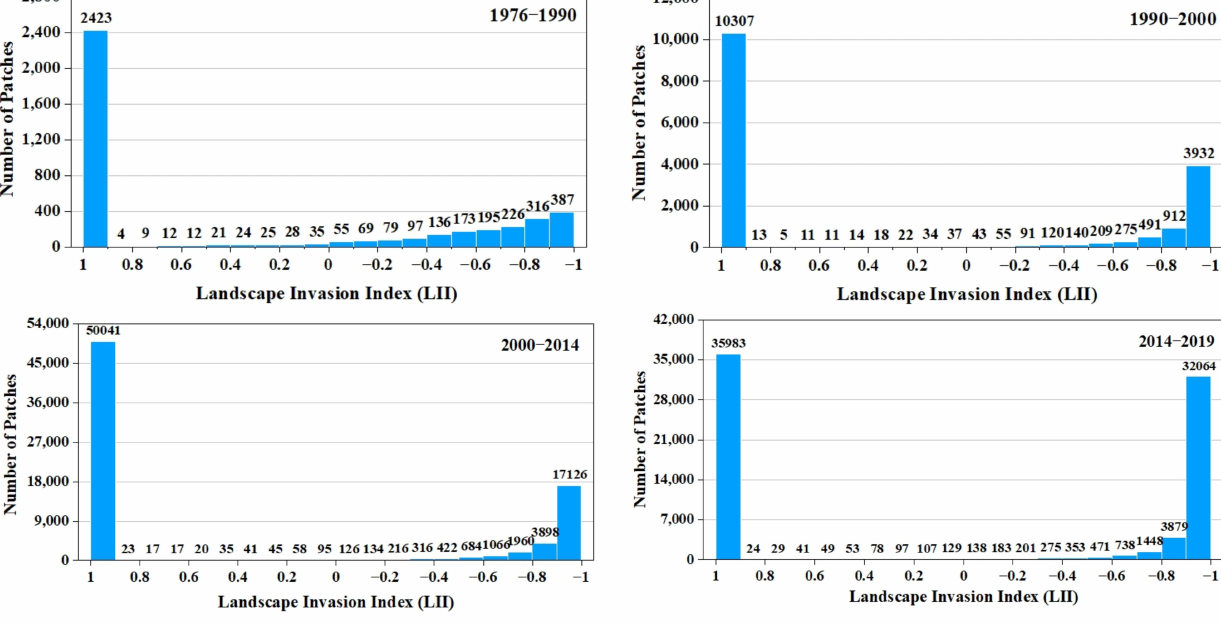
Figure 7. The LII histogram of wetland invaded by built-up land by time periods of from 1976 to 1990, from 1990 to 2000, from 2000 to 2014, from 2014 to